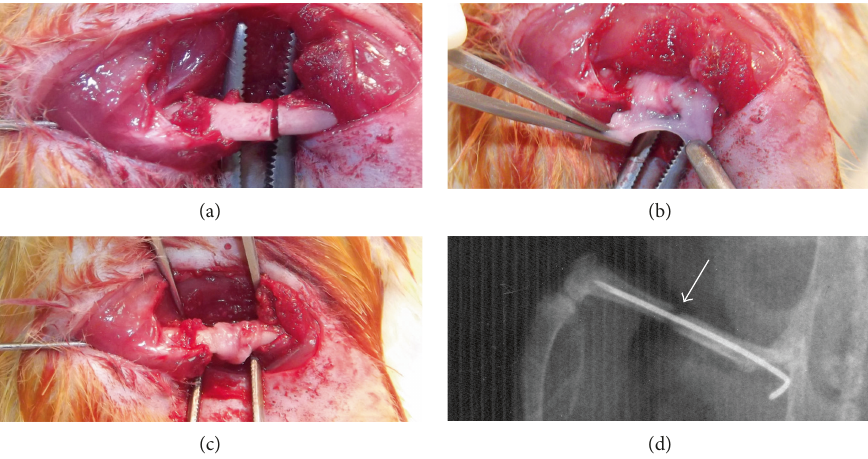
Figure 3: Application of MSC sheets onto the osteotomy sites in a rat fracture model. A 1 mm segmental bone defect was created by transverse osteotomy on rat femurs in this study (a). MSC sheets were wrapped around the fracture sites individually (b, c), and incisions on hind limbs were sutured. Postoperative control radiographs were taken after intramedullary fi xation of fractures